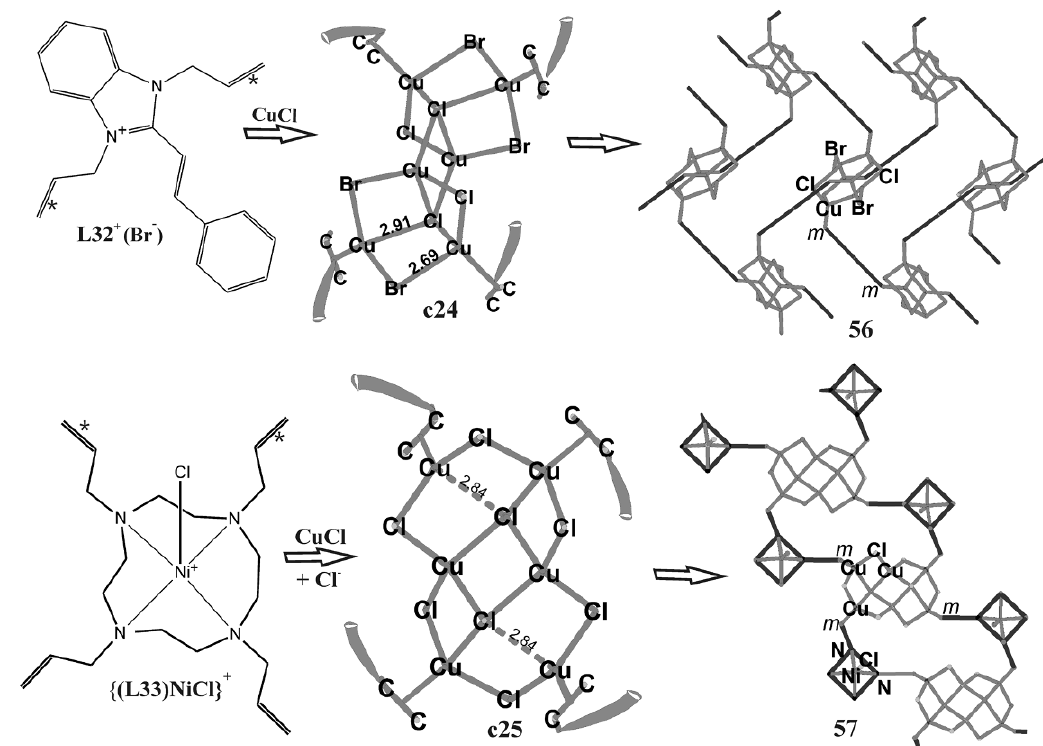
Figure 12. Structural genesis of C24 and C25 fragments in 56 and 57 compounds.